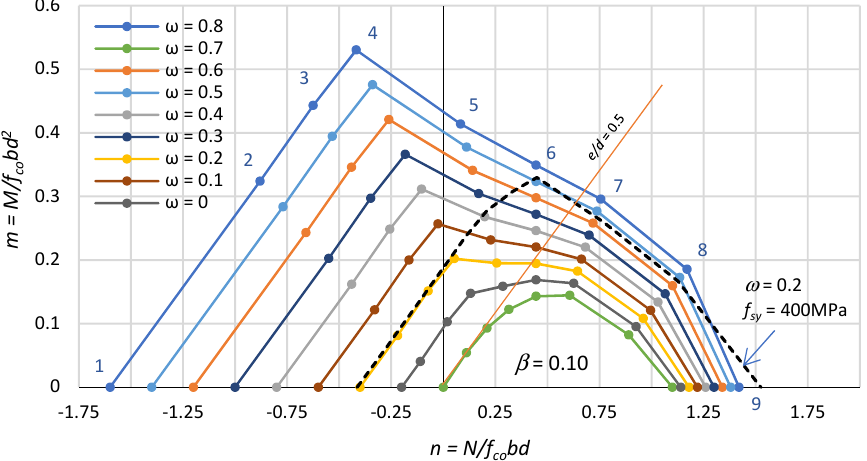
Figure 4. Effect of reinforcement intensity ω on the interaction n–m.